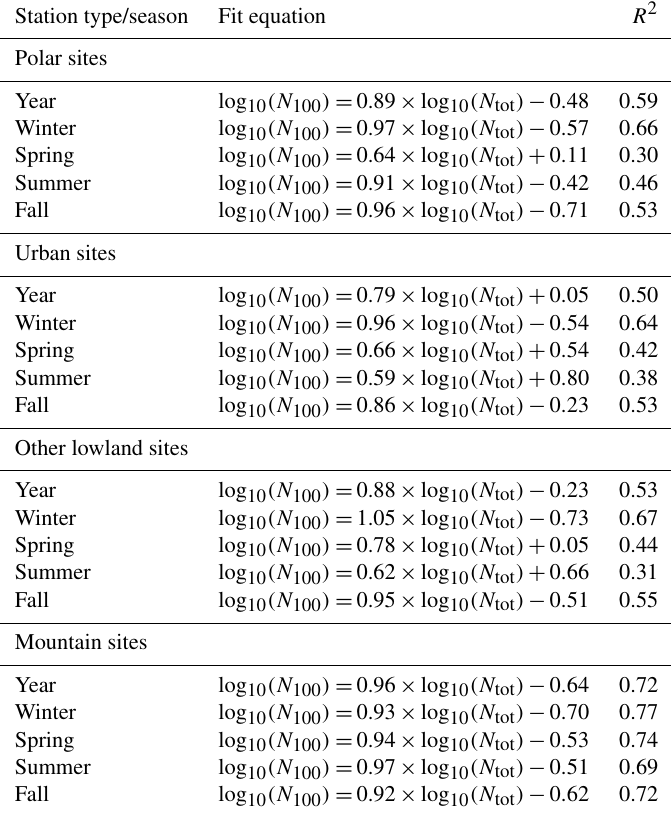
Table 2. Connection between N 100 , the particle number concentration in the range of 100–500nm, used as a proxy for the CCN population, and N tot . For each station type and season, the equation of the linear fit performed on the logarithm of the data is reported in the second col- umn, and the corresponding coefficient of determination in the third column. Note that based on the corresponding p values, all correlations were found to be significant at the 95% confidence level ( p< 0 .